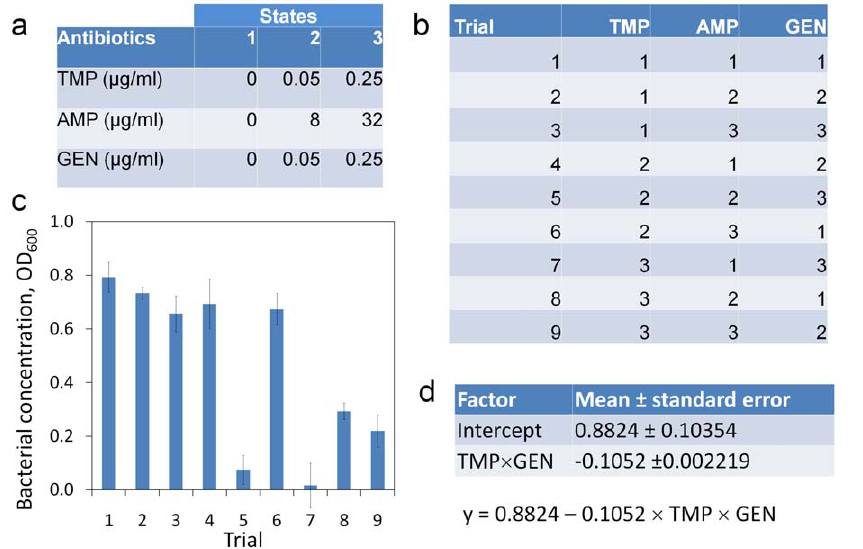
Figure 2. A 3-drug experiment for demonstrating the concept of the MACO scheme. (a) Three concentration levels for each antibiotic are assigned. (b) Fractional factorial experimental design for the three antibiotics considered in this experiment. 9 experimental trials are required. (c) Results of antibiotic susceptibility testing on trials defined in (b). (d) Result of the regression analysis based on the factorial regression and quadratic response surface models. TMP=trimethoprim; AMP=ampicillin; GEN=gentamicin. Data represent absorbance 6 standard deviation obtained from 4 independent measurements.